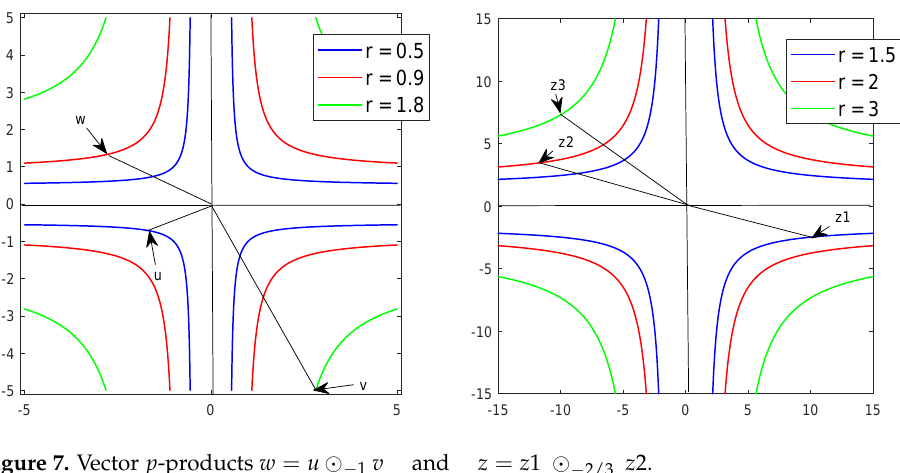
Figure 7. Vector p -products w = u (cid:12) − 1 v and z = z 1 (cid:12) − 2/3 z